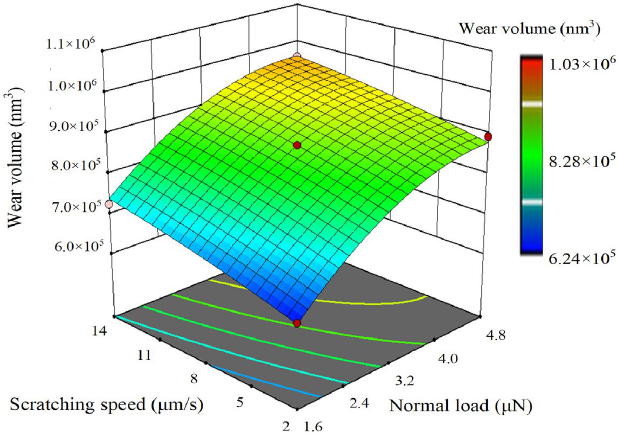
Figure 14. Three-dimensional response surface of wear volume.